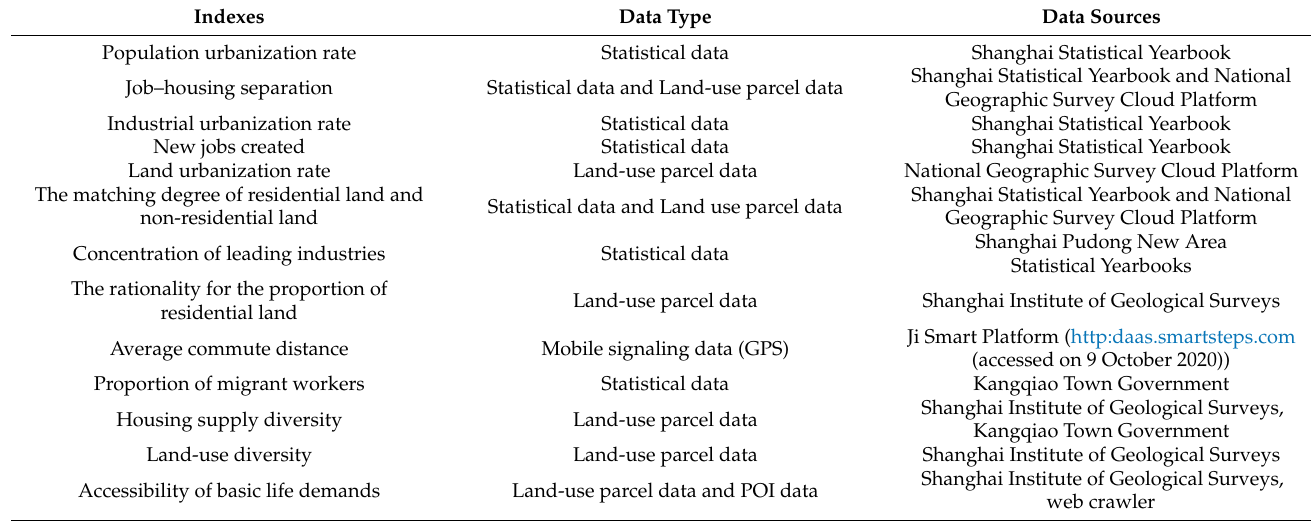
Table 6. Data type and sources of the index system of city–industry integrated development.